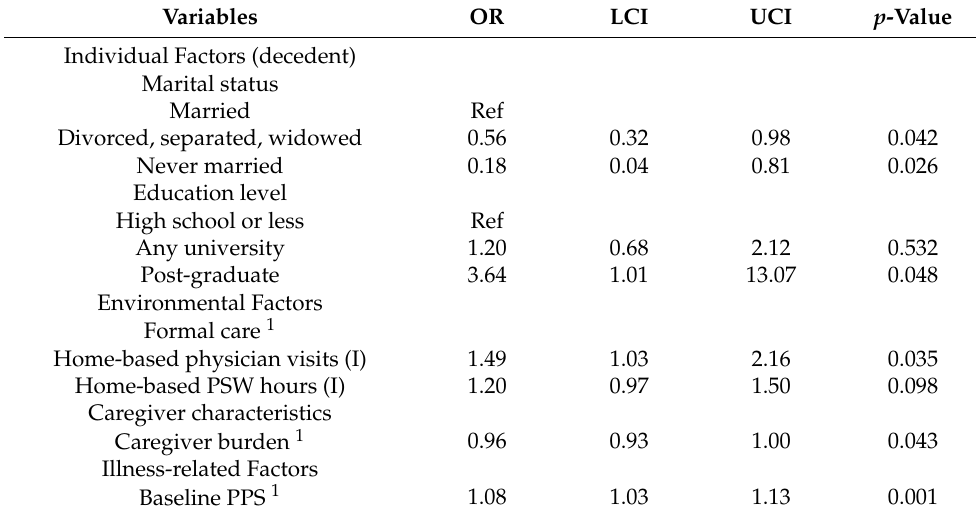
Table 2. Multivariate odds ratios for likelihood of preferred home